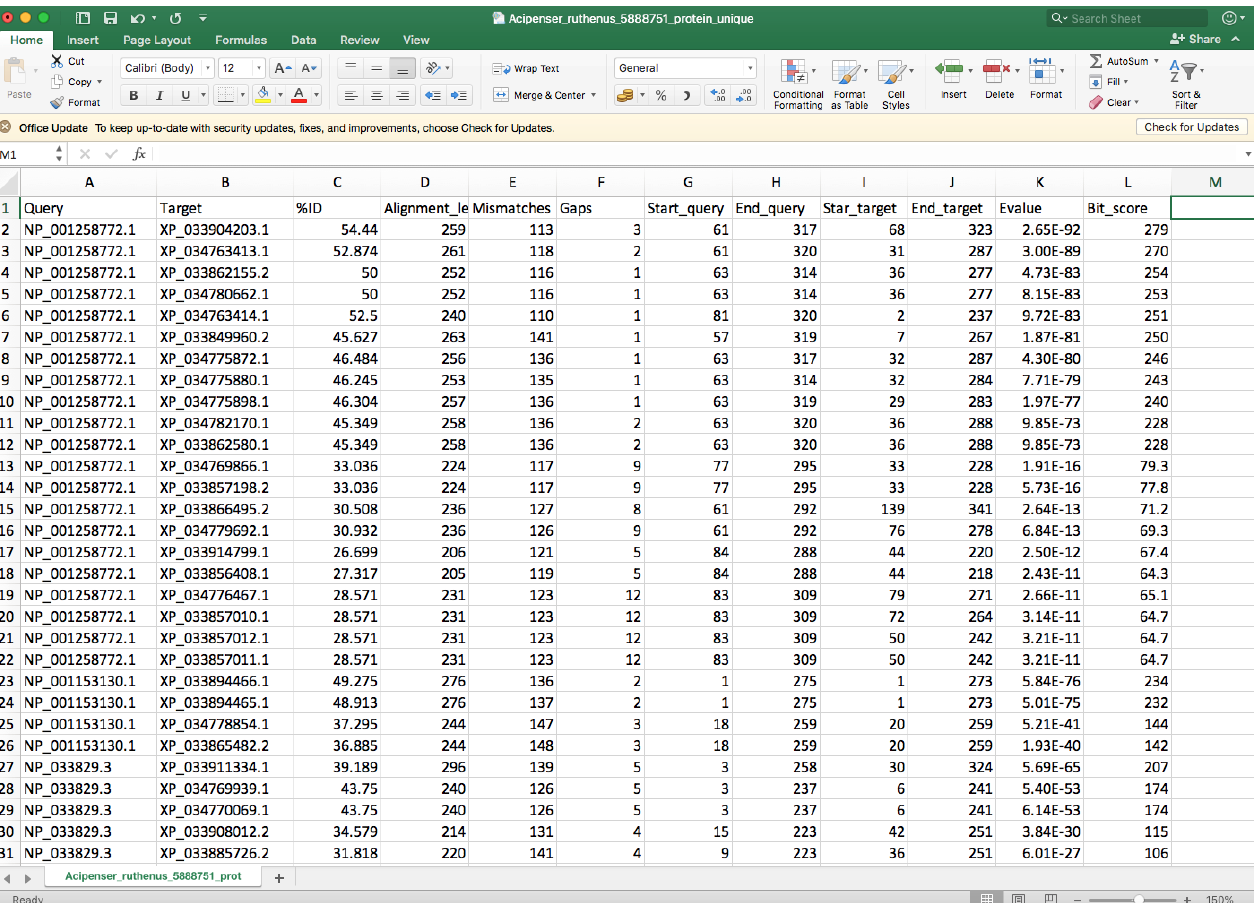
Figure 8. Example of a BLAST output file viewed in Excel.